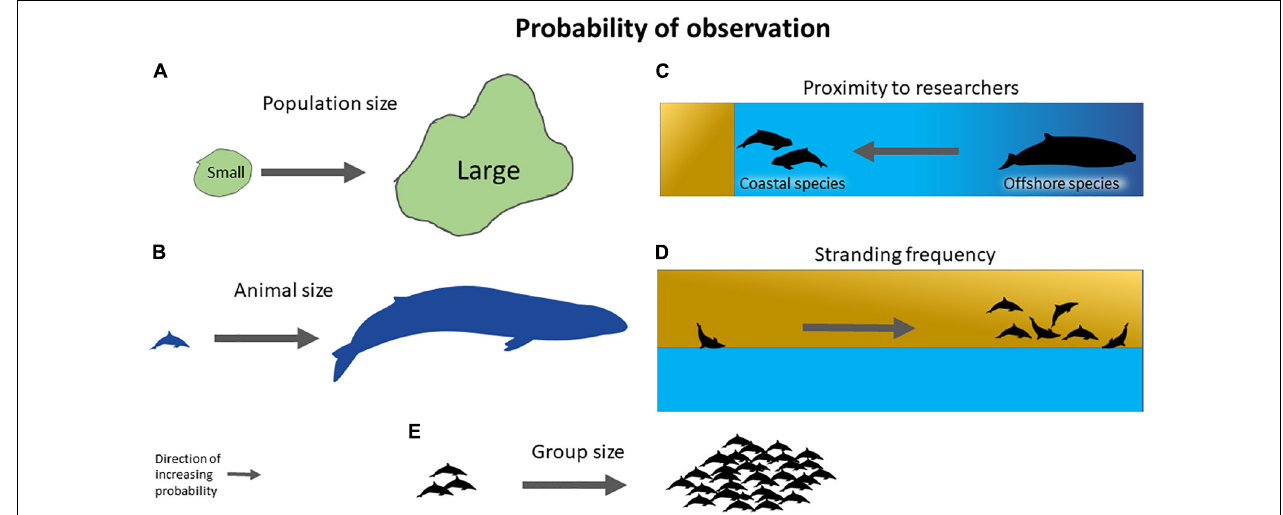
FIGURE 1 | The probability of observation and data collection hinges on the theoretical framework that (A) species with larger population sizes will have more chances of being observed in the field, (B) larger species may be easier to find than smaller species, (C) coastal species may be easier to find and observe than offshore species, (D) species that strand more often may provide accessible data for research that are otherwise difficult to obtain, and (E) species that form larger group sizes may have higher chances of being found than species that are solitary or form smaller groups. The arrows indicate direction of increased probability.